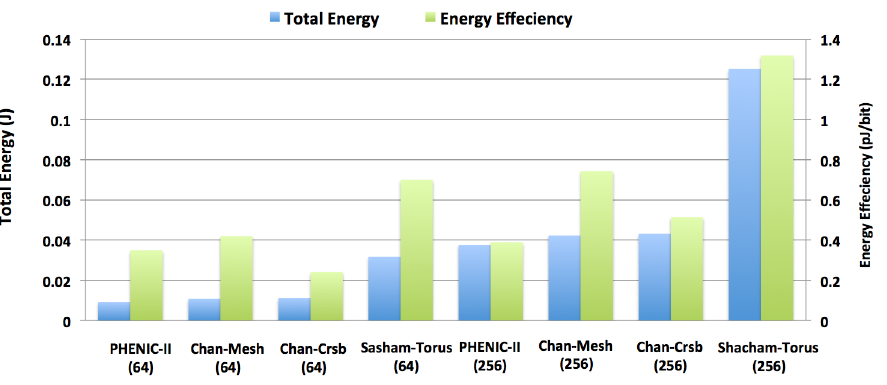
Figure 14. Total energy and energy efficiency comparison results under random